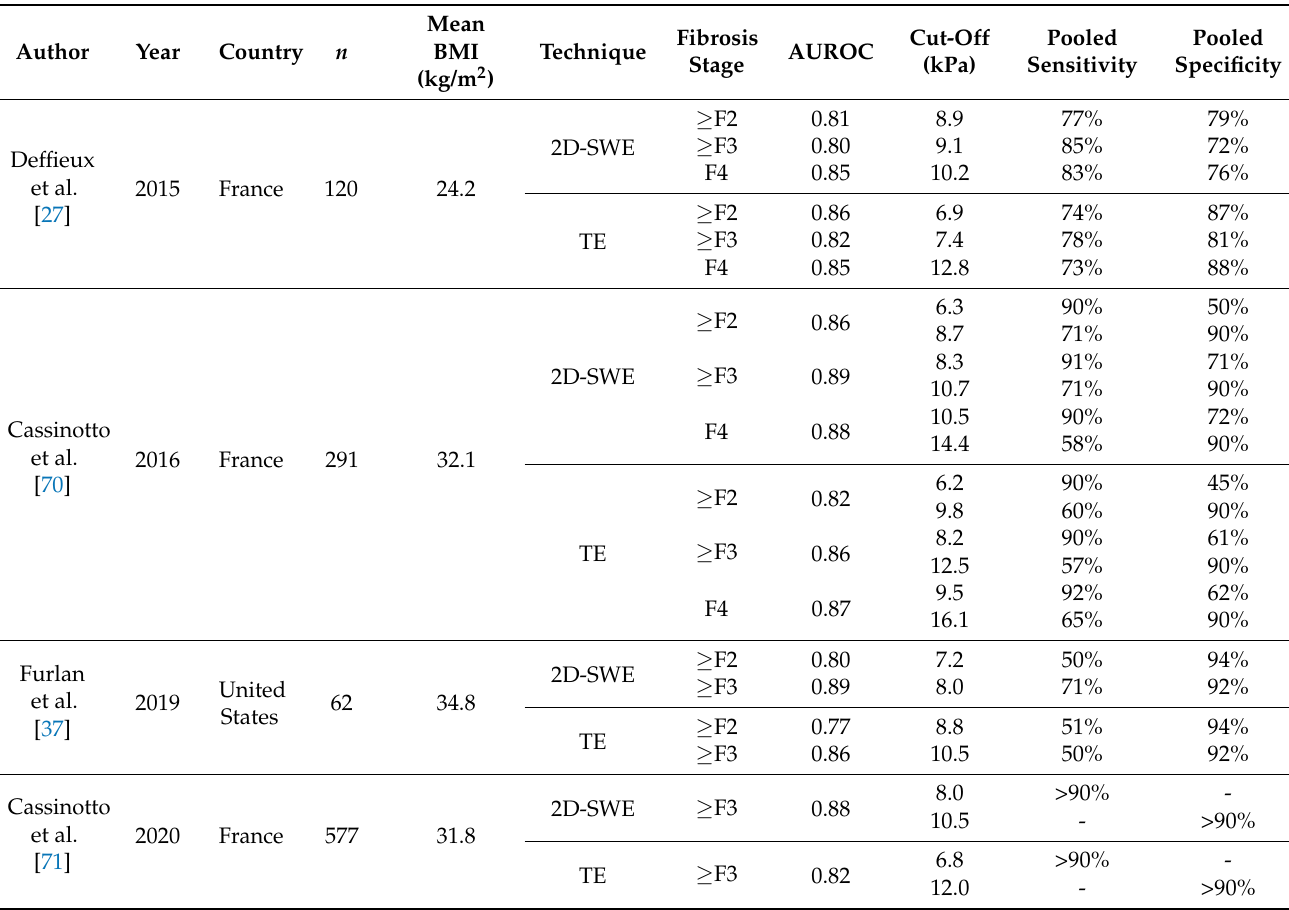
Table 2. Diagnostic performance of 2D-SWE and transient elastography (TE) for different fibrosis stages in patients with NAFLD.